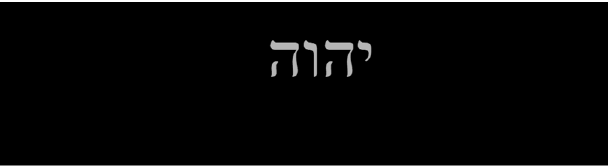
Figure 1. The Tetragrammaton (read right to left).